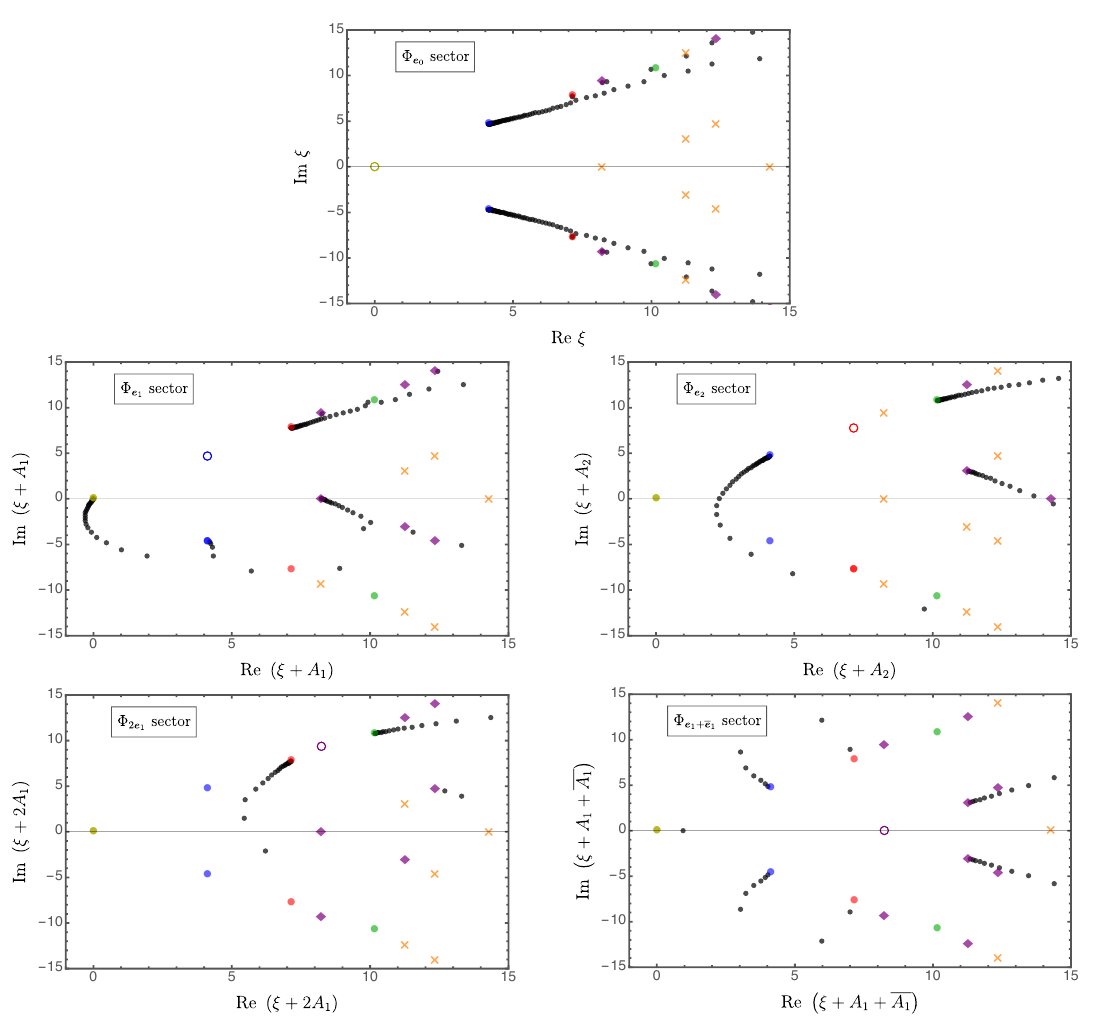
Figure 1 . The singularity structure (grey dots) in the complex (cid:24) -plane (Borel plane) associated to the Borel transforms of sectors (cid:8) n , with n = 0 ; e 1 ; e 2 ; 2 e 1 ; e 1 + e 1 . This singularity structure is obtained via the poles of the respective Borel-Pad(cid:19)e approximant (of order N ) BP N [(cid:8) n ]. The Borel- Pad(cid:19)e approximants used were: BP 189 [(cid:8) 0 ], BP 135 [(cid:8) e ], BP 129 [(cid:8) e ], BP 47 [(cid:8) 2 e ] and BP 47 [(cid:8) e ]. 1 2 1 1 + e 1 The Borel planes have been shifted to be represented on a common axis, with the expansion points shown by a hollow circle and the hydrodynamic expansion located at the origin (in dark yellow). The predicted branch points for each sector (listed in appendix A) have been superimposed on each Borel plane and are divided into fundamental (solid circles) and mixed sectors (purple diamonds). The fundamental sectors include: A 1 and A 1 (blue), A 2 and A 2 (red), A 3 and A 3 (green). Any branch points associated to sectors of the transseries which do not give origin to branch points are shown as orange